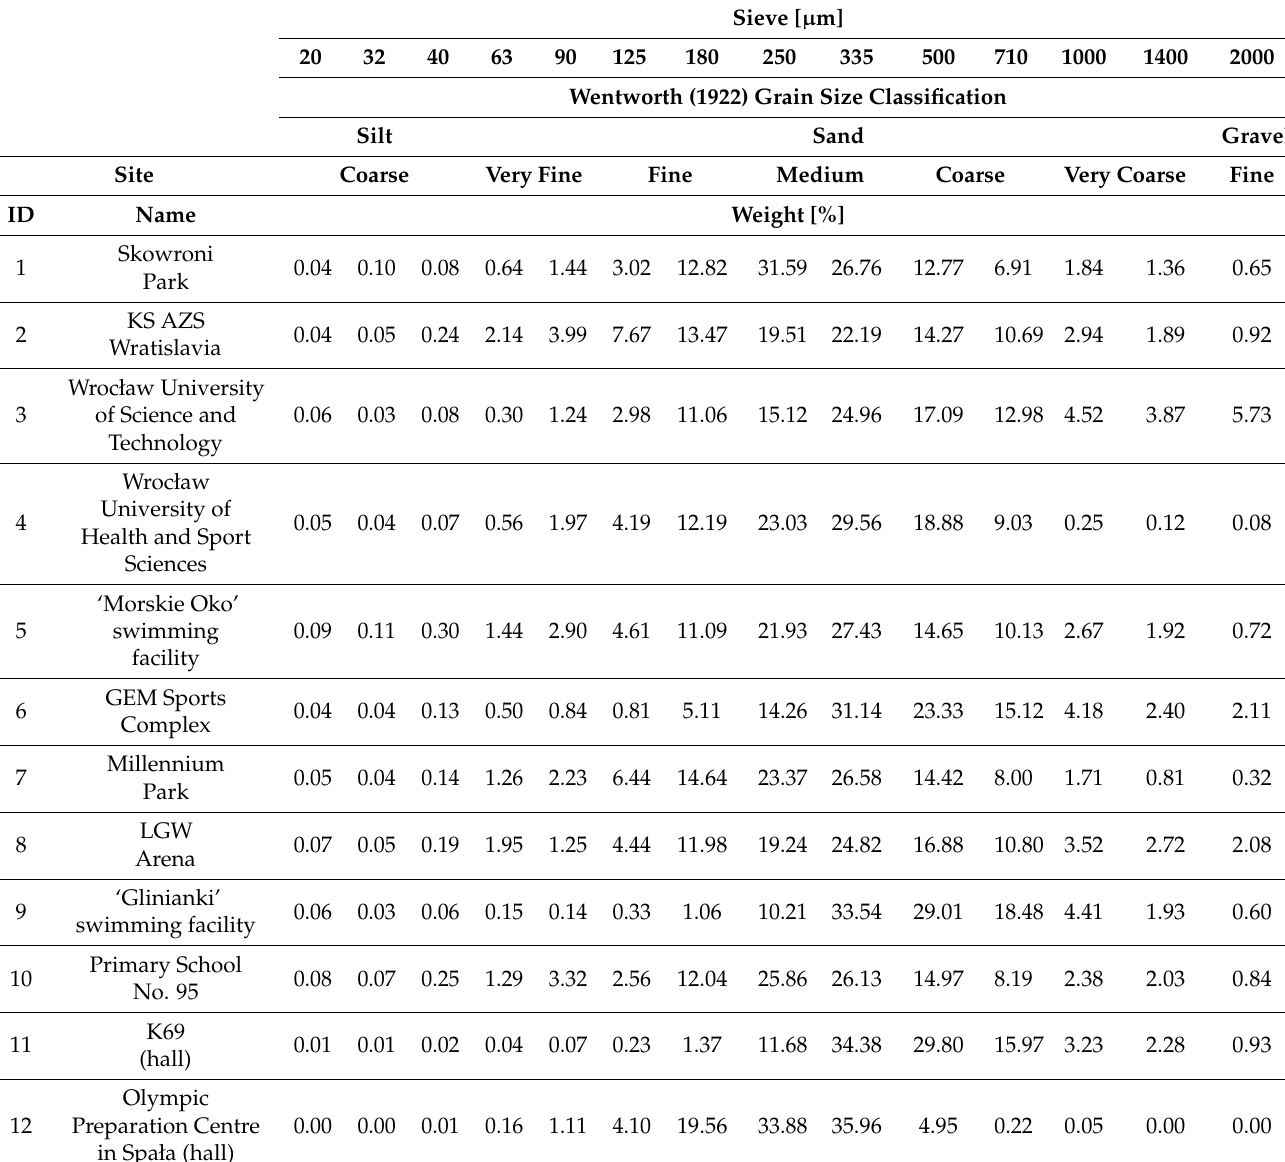
Table 2. Percentage of granulometric fractions in collected samples according to Wentworth’s classifi- cation